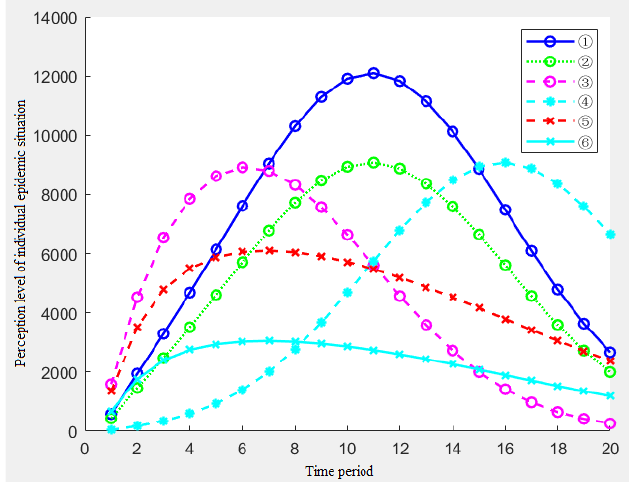
Figure 9. Change of the epidemic perception when the information stimulation first increases and then decreases.